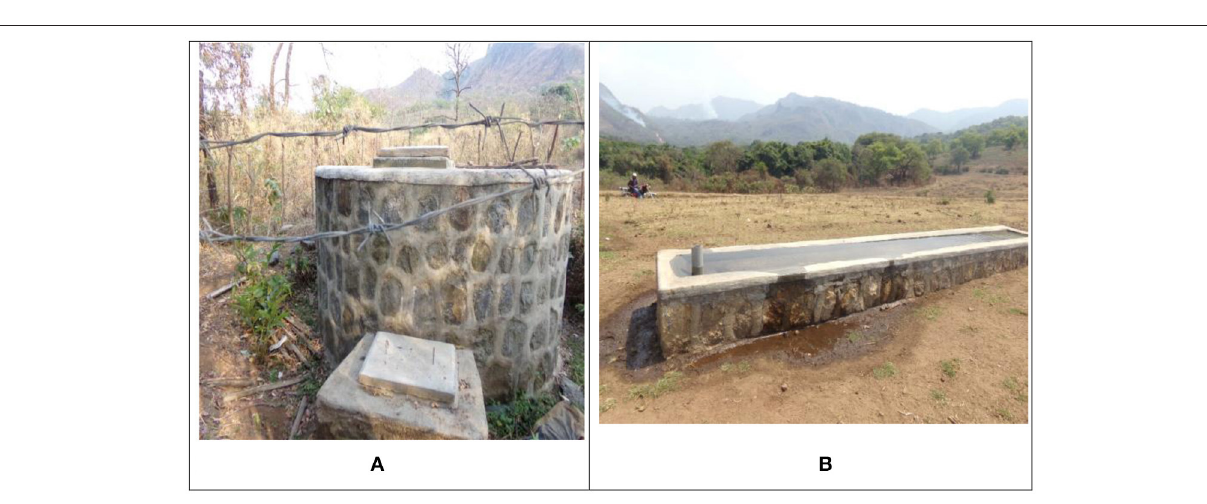
as the low adaptive capacities of farmers (IPCC,